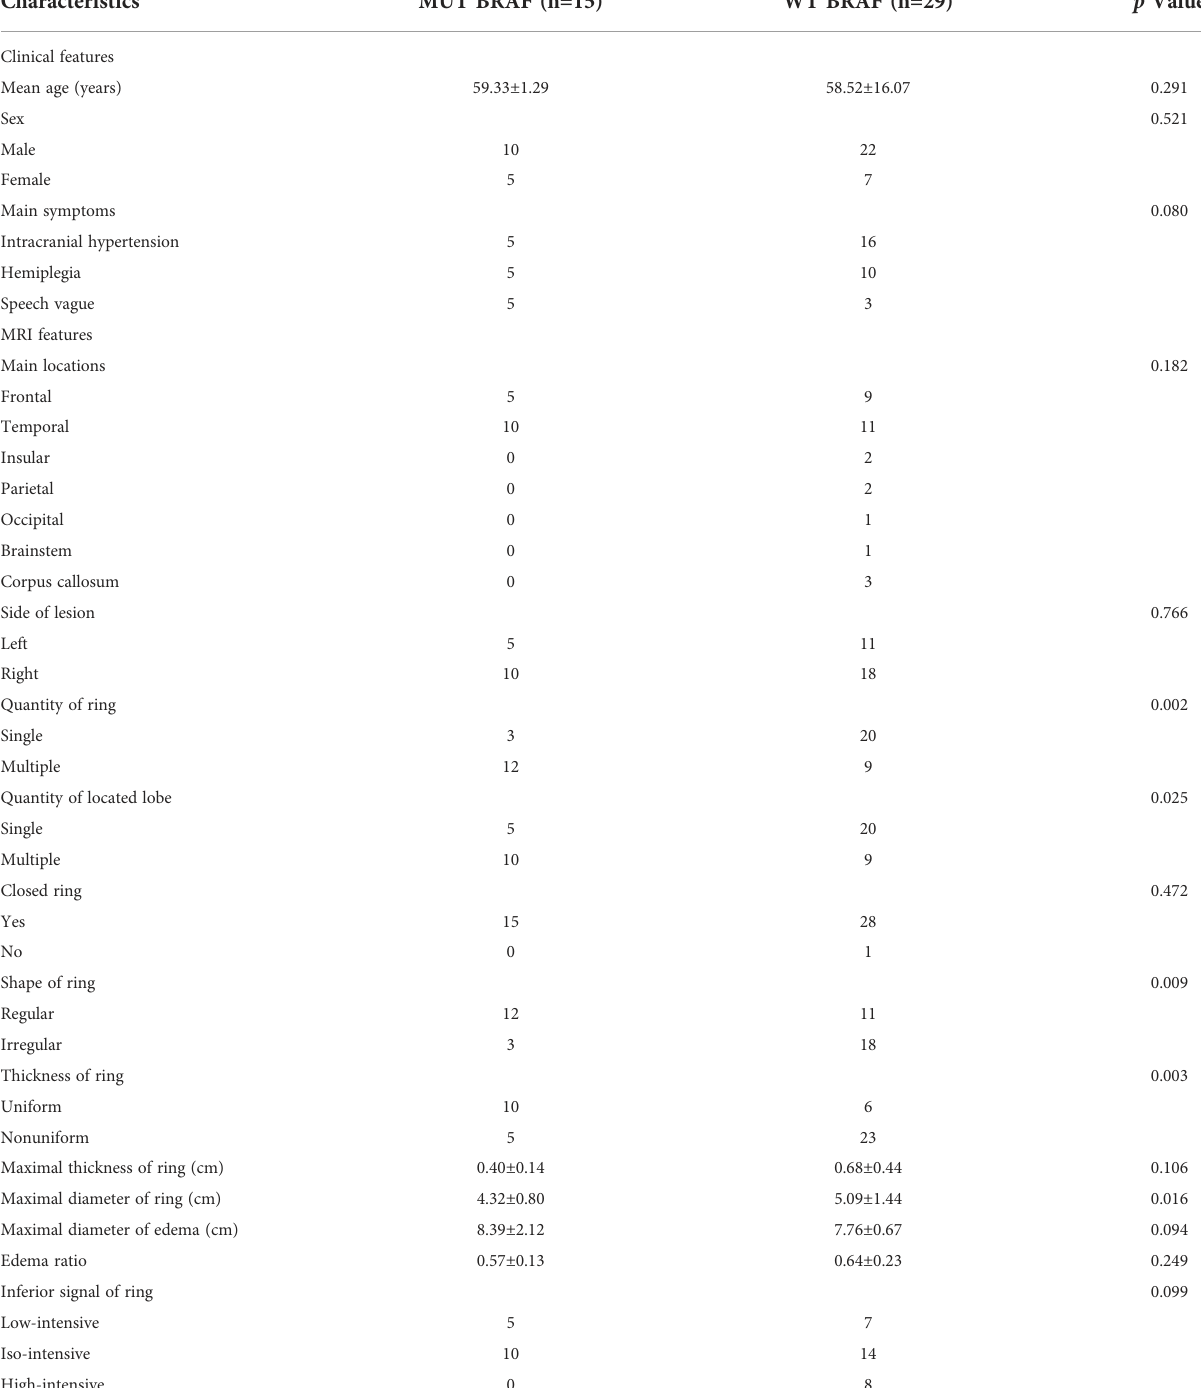
TABLE 1 Demographics and clinical characteristics of GBM cases strati fi ed by BRAF mutation